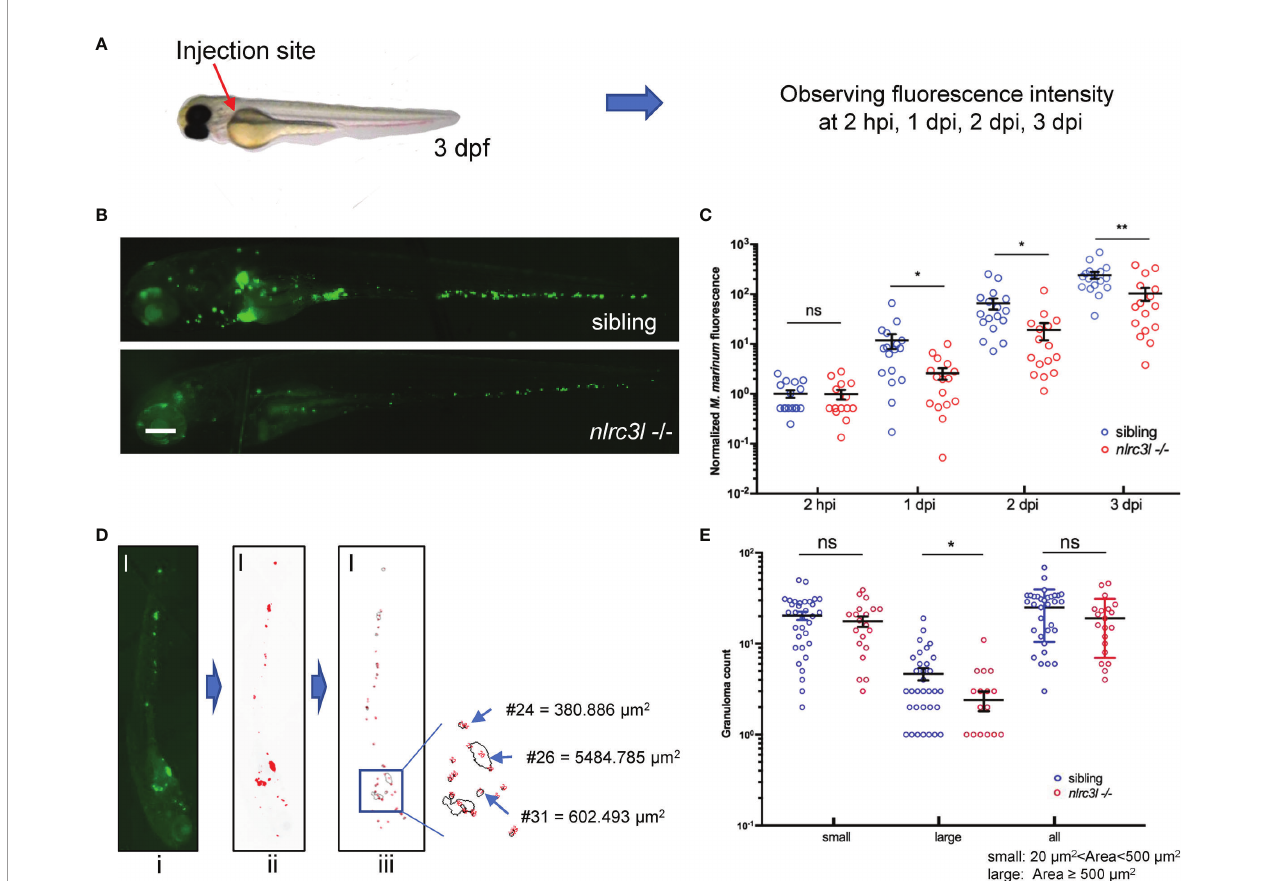
FIGURE 1 | nlrc3-like de fi ciency promotes host control of the mycobacterial proliferation during early infection. (A) Zebra fi sh embryo infections and bacterial fl uorescence intensity. The red arrow indicates the duct of Cuvier, the site where bacteria were injected. (B) Representative images for M. marinum : Wasabi infected embryos at 3 dpi. (C) Statistics of relative green fl uorescence intensity at the indicated time points taken from two independent biological replicates. (D) Process for calculating granuloma-like structure in zebra fi sh embryos: i original image; ii. the image after fl uorescence-pixelation processing – the area of the red pixels represents the relative size of each granuloma; iii. Calculation of the area of the red pixels. (E) Graph showing the number of large, small and all granuloma-like structures in nlrc3-like -/- and control embryos. (B, D) Scale bar = 200 m m *p ≤ 0.05; **p ≤ 0.01; ns, not statistically signi fi cant